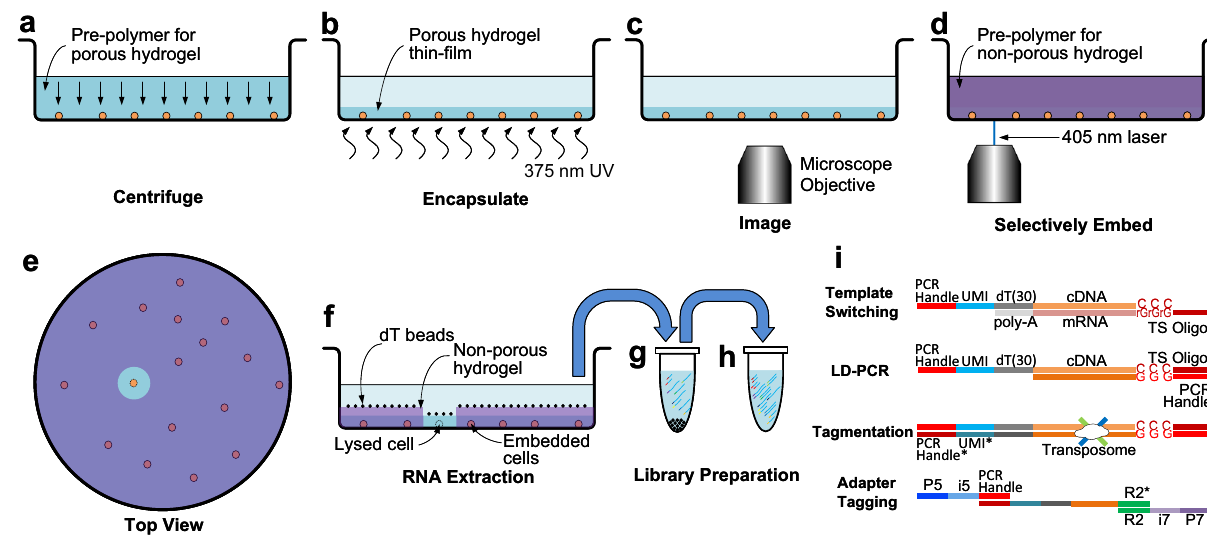
Fig. 1 Selective single cell RNA sequencing using See-N-Seq. a The cell sample is distributed in imaging microwell plates with the pre-polymer for the porous hydrogel and aligned by centrifuging. b The cells are encapsulated in a porous hydrogel thin- fi lm formed by exposure to 375 nm UV light. c Encapsulated cells are imaged by microscopy to identify a target cell in each well. d The pre-polymer for the non-porous hydrogel penetrates inside the porous hydrogel and is micropatterned using a scanning 405 nm laser. e (Top view) All cells except for the target cell are embedded in the non-porous hydrogel. f mRNA from the target cell is captured by oligo-dT beads. g The oligo-dT beads are transferred to a tube where mRNA is eluted, UMI-barcoded, and reverse transcribed with a template switching oligo. h The cDNA library is ampli fi ed by long distance PCR (LD-PCR). i Library preparation steps include template switching, LD-PCR, tagmentation, and adaptor